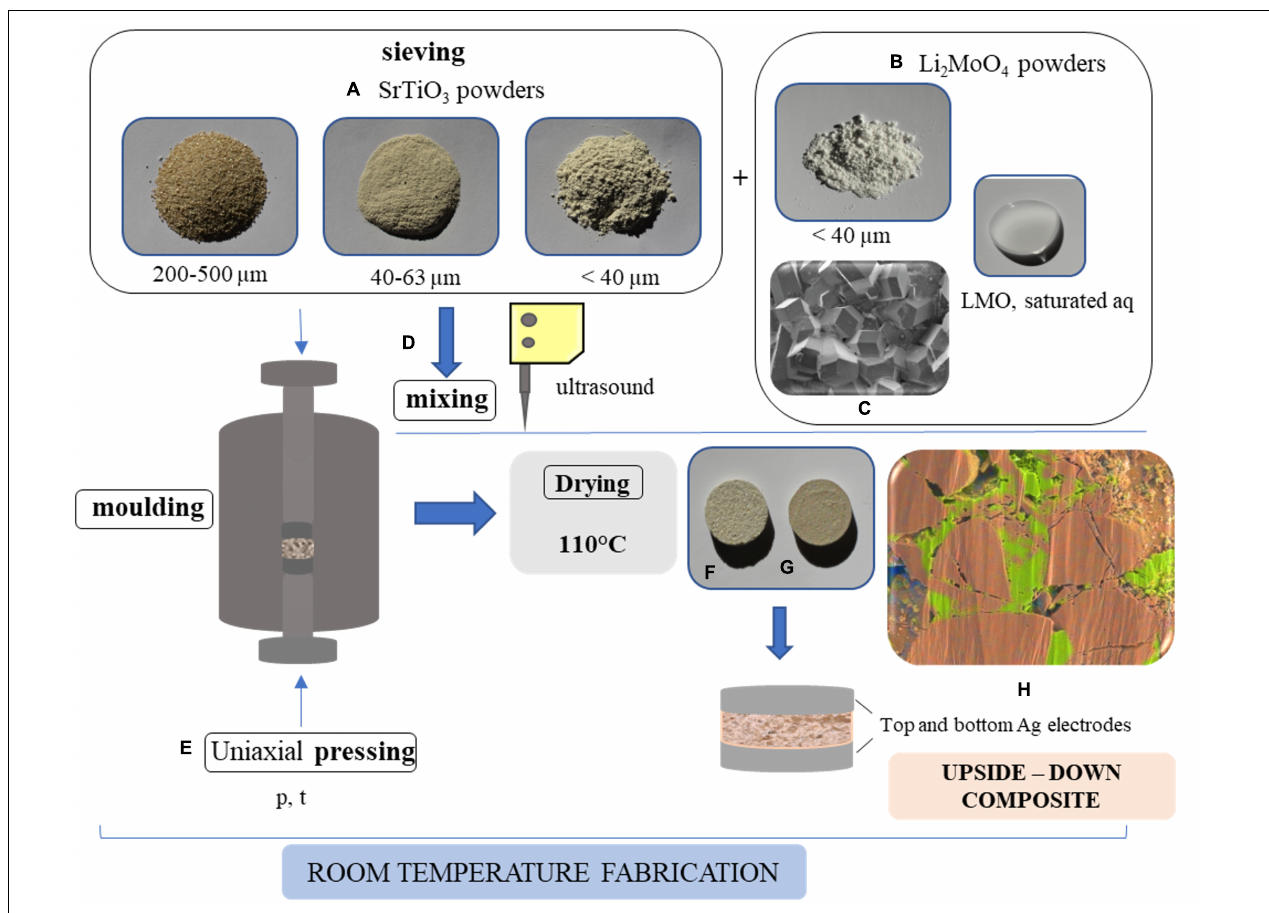
FIGURE 1 | The experimental preparation protocol of upside-down LMO-ST composites is shown on the processing scheme. The initial components showed (A) ST sintered powder, which was subsequently sieved into three different fractions, and (B) LMO binder present in a solid phase (40 µ m) as well as in saturated aqueous solution. (C) SEM micrograph of LMO crystals. (D) Mixing assisted by ultrasonic treatment. (E) Uniaxial pressure assisted densification. (F) Dried and densified pellet. (G) A densified pellet with silver electrode applied. (H) EDS mapping of the final LMO-ST